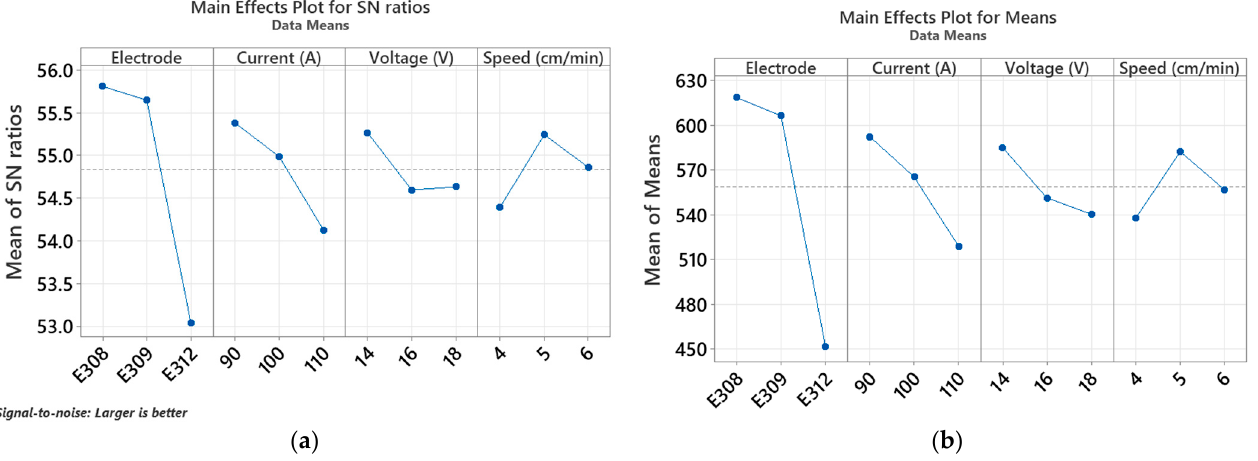
Figure 6. S/N ratio and mean response graphs for maximum flexural force; ( a ) Mean of S/N ratios and ( b ) Mean of Means.